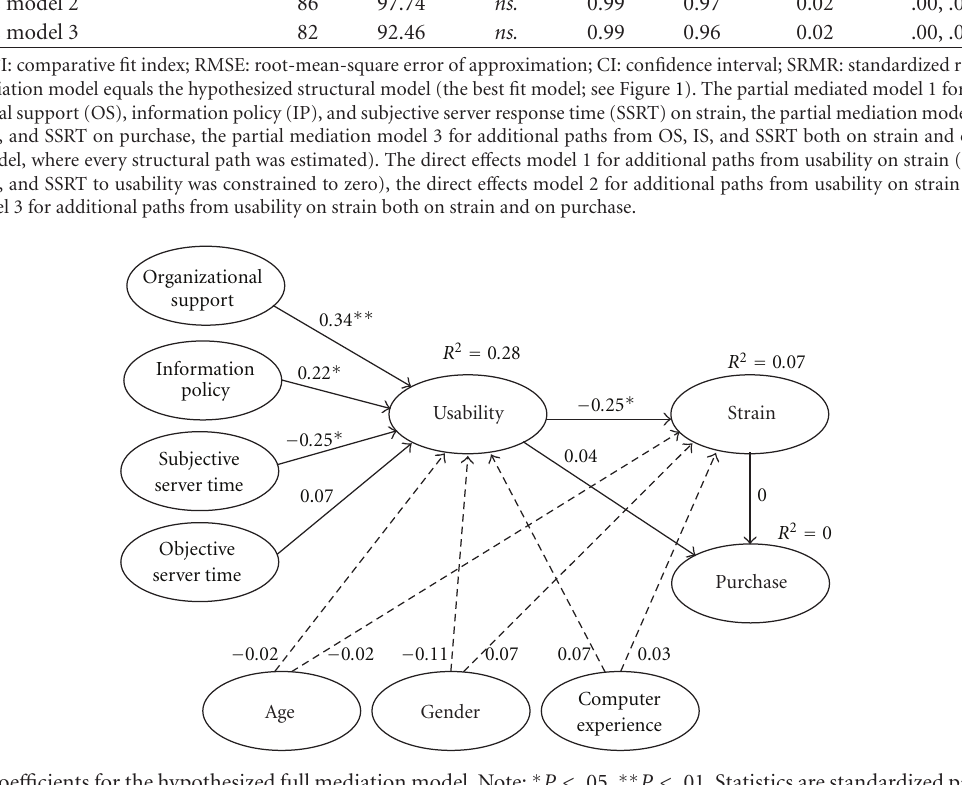
Figure 1: Path coe ffi cients for the hypothesized full mediation model. Note: ∗ P < . 05. ∗∗ P < . 01. Statistics are standardized path coe ffi cients. Hypothesized e ff ects are depicted as straight lines, and control e ff ects as dotted lines. Predictors were allowed to intercorrelate, as were the error terms of the usability